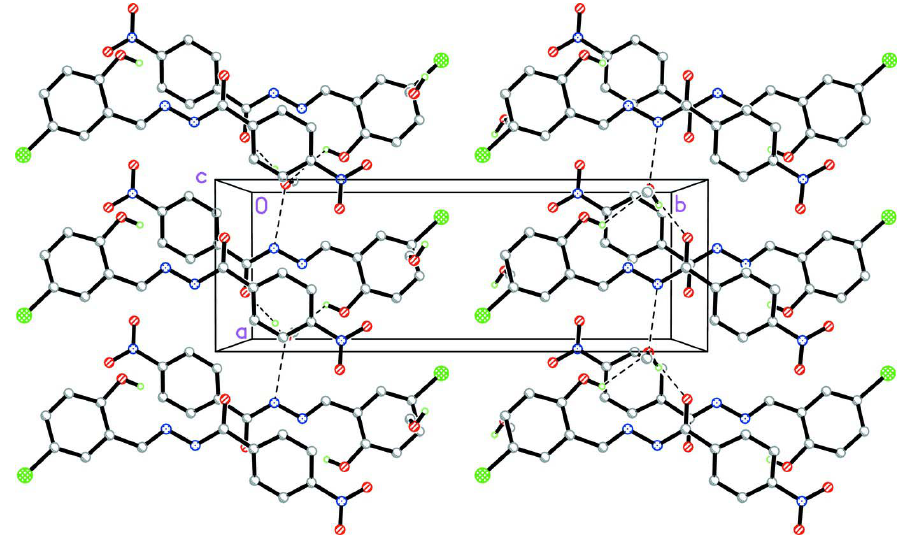
Figure 2 Crystal packing of the compound viewed along the c axis. Intermolecular hydrogen bonds are shown as dashed lines. H atoms not involved in the interactions have been